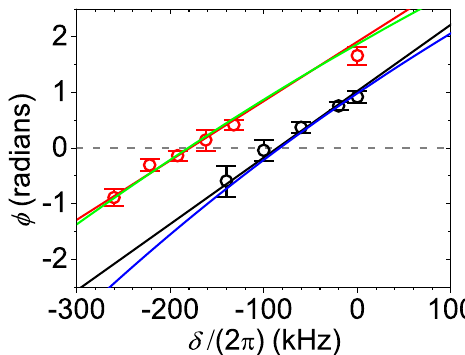
Fig. 4 Determination of the two-photon detuning for the zero phase shift. Black (or red) circles are the experimental data of phase shift versus two- photon detuning measured at α (optical depth) = 82, Ω c = 1.0 Γ , Δ c = 1.0 Γ , and Ω p = 0.10 Γ (or 0.20 Γ ). Black and red lines represent the linear best fi ts. We determined the two-photon detuning, δ 0 , for the zero phase shift, i.e., ϕ = 0, by the intersection between the best fi t and the gray dashed line. As references, blue and green lines are the theoretical predictions calculated numerically 54 . The error bars represent the standard deviation of measured